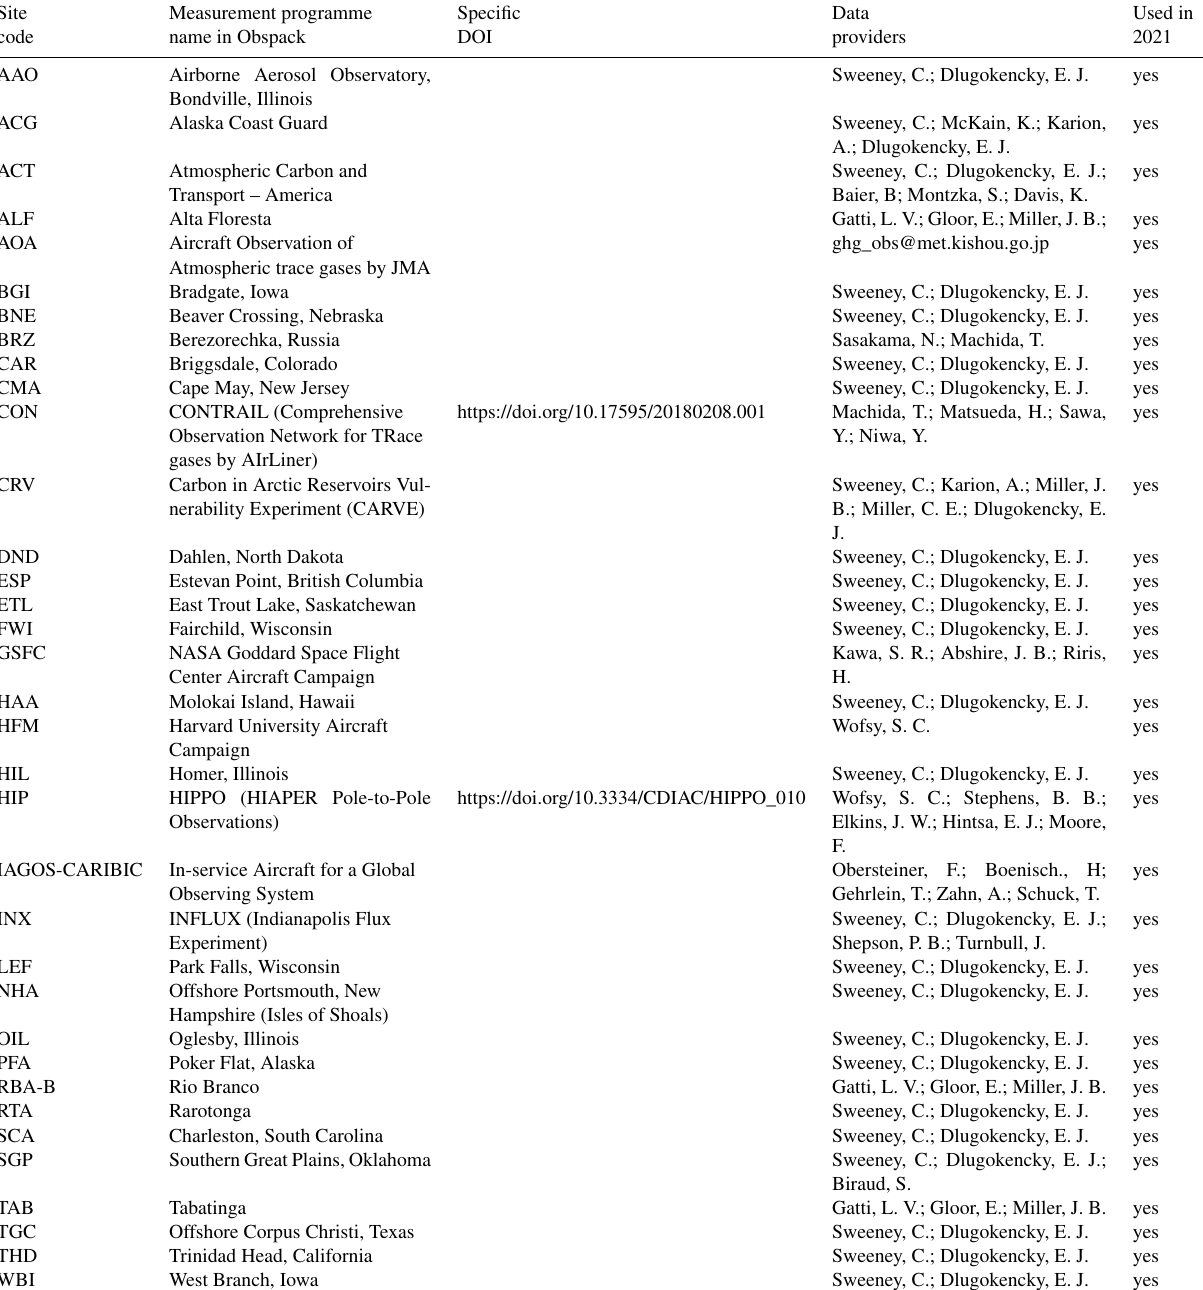
Table A6. Aircraft measurement programmes archived by Cooperative Global Atmospheric Data Integration Project (CGADIP; Cox et al., 2021) that contribute to the evaluation of the atmospheric inversions (Fig.